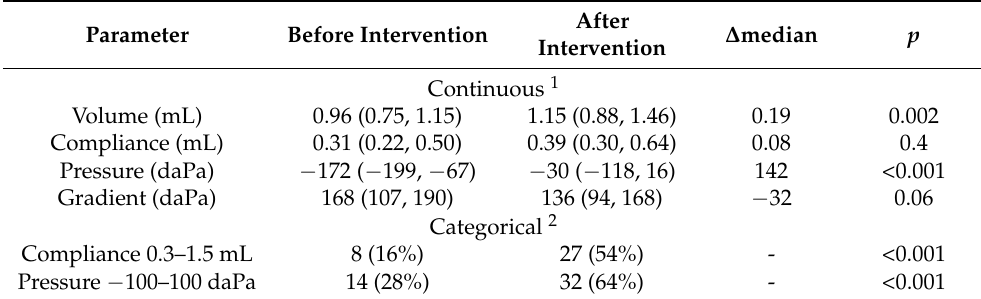
Table 2. Tympanometry parameters expressed as continuous and categorical variables before and after the administration of the intervention.